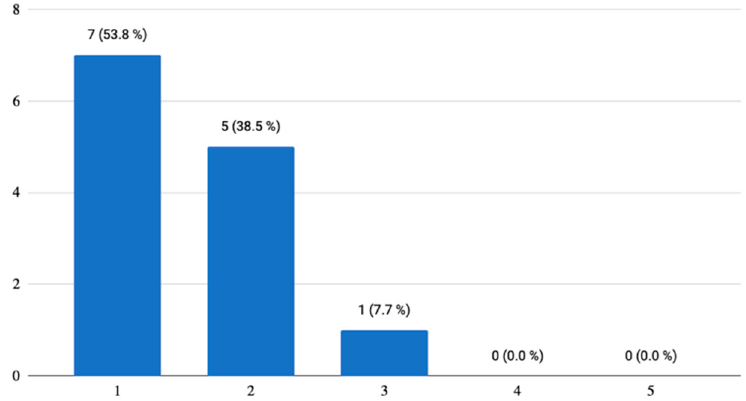
Figure 10. Overall evaluation of the mobile application.